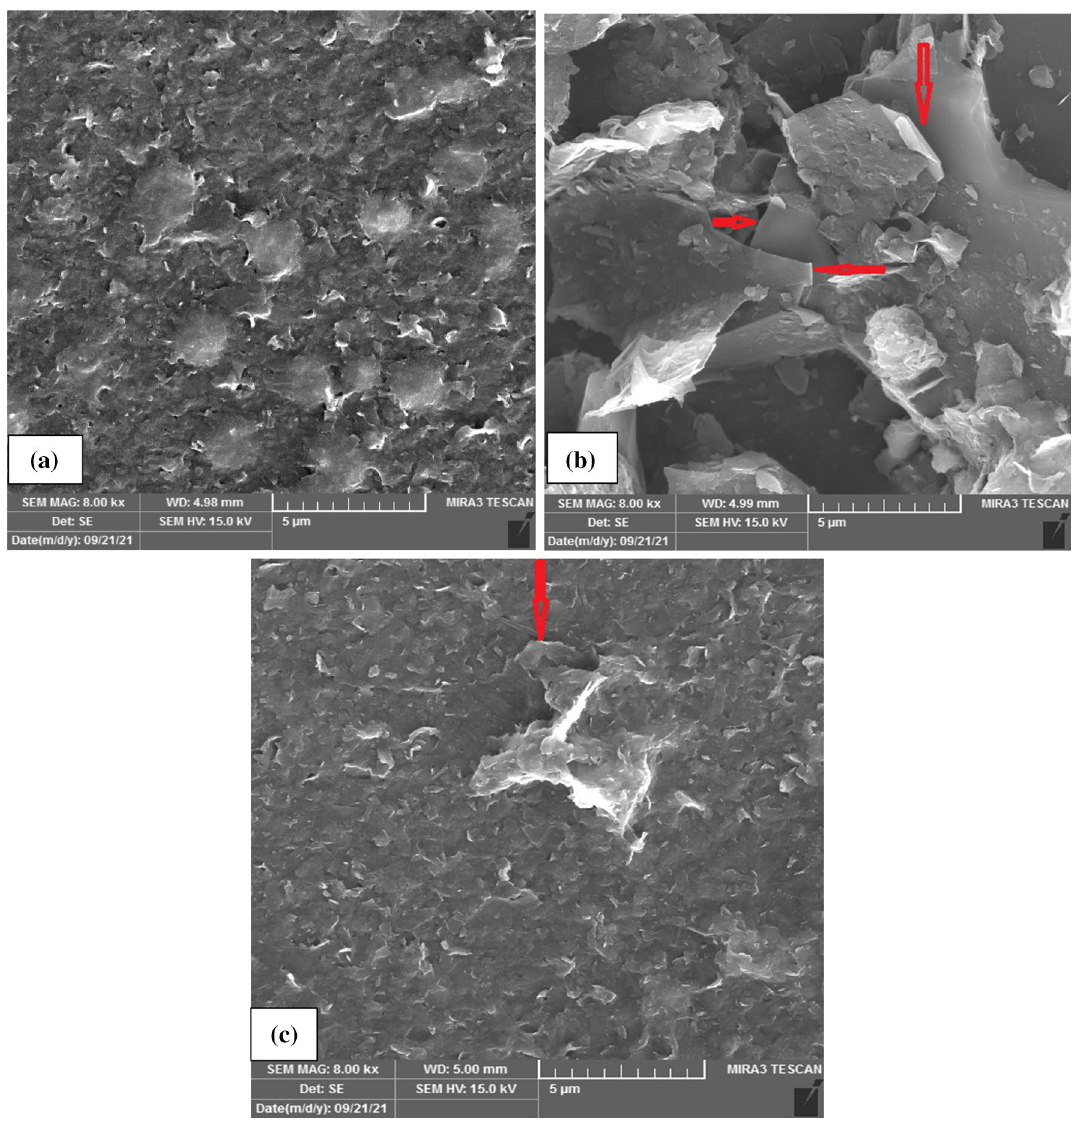
Figure 9. SEM micrographs of graphene flakes for different sonication time duration: ( a ) 25 min, ( b ) 55 min and ( c ) 65 min (scale bars is 5